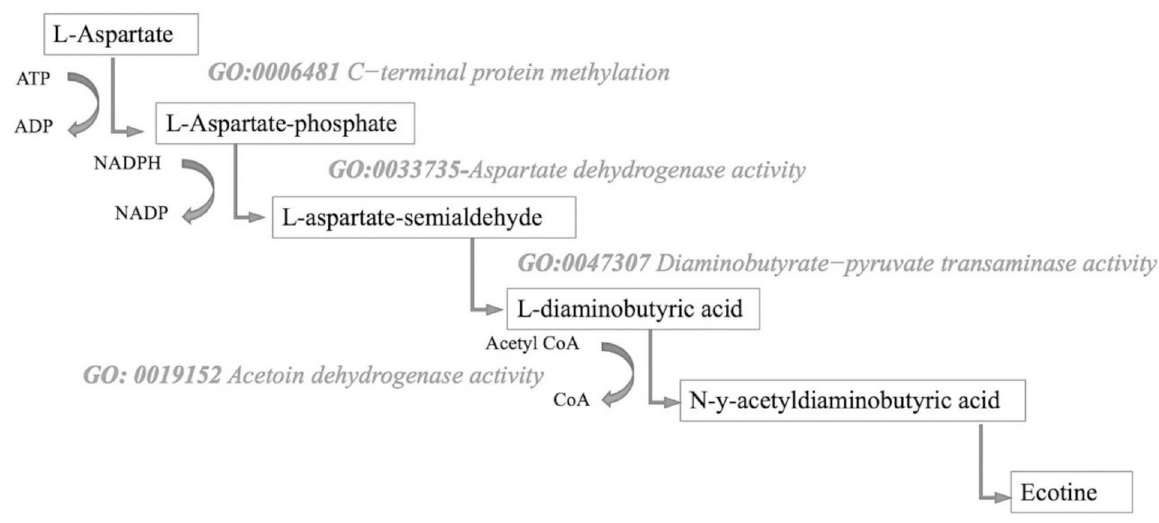
Fig 3. GO terms increased in the IGT related to the ectoine biosynthetic pathway cascade. From [30]. Copyright 2015, by He, Y. Z., Gong, J., Yu, H. Y., Tao, Y., Zhang, S., & Dong, Z. Y.